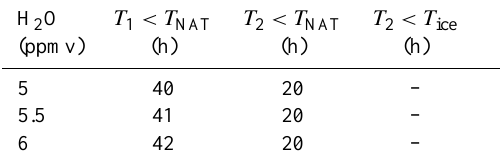
only a few PSCs were detected which were located around Greenland 2 .